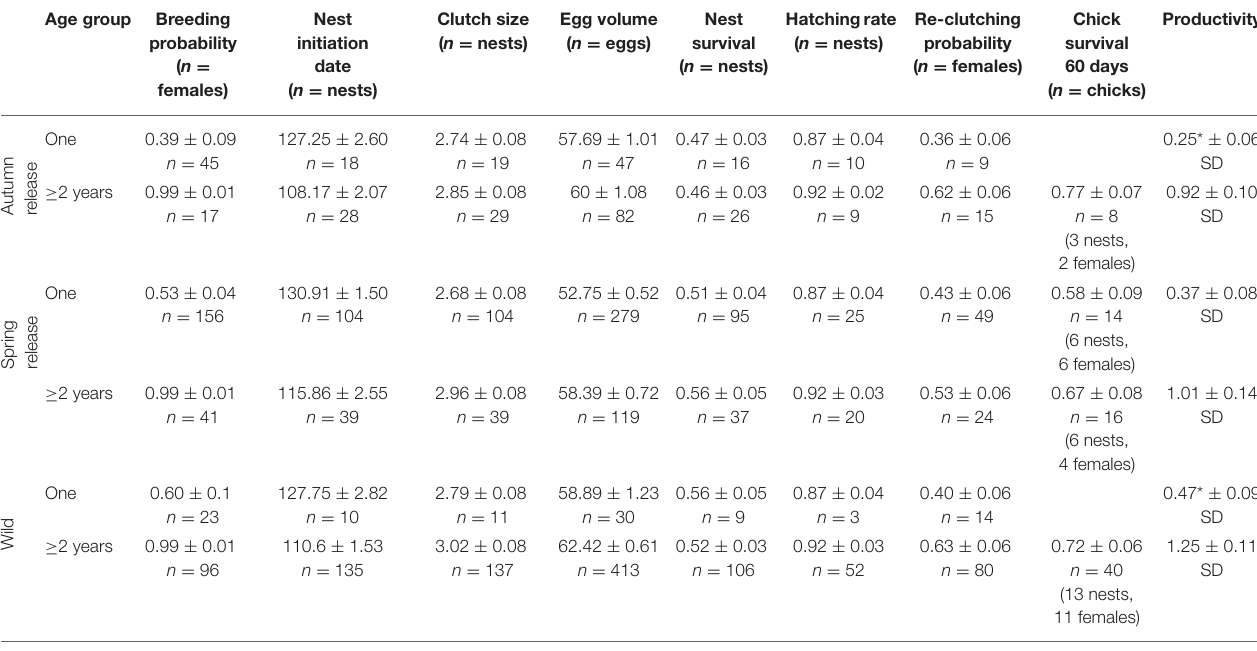
TABLE 1 | Mean ( ± SE) breeding parameters for wild, and captive-bred migrant Asian houbara ( Chlamydotis macqueenii ) released in autumn (late August to the end of September) and spring (late March to early May of the following year) and from two age groups: one (females < 2 years old) and ≥ 2 years (females two or more years old). Age group Breeding Nest Clutch size Egg volume Nest Hatchingrate Re-clutching Chick Productivity probability initiation ( n = nests) ( n = eggs) survival ( n = nests) probability survival ( n = date ( n = nests) ( n = females) 60 days females) ( n = nests) ( n = chicks)